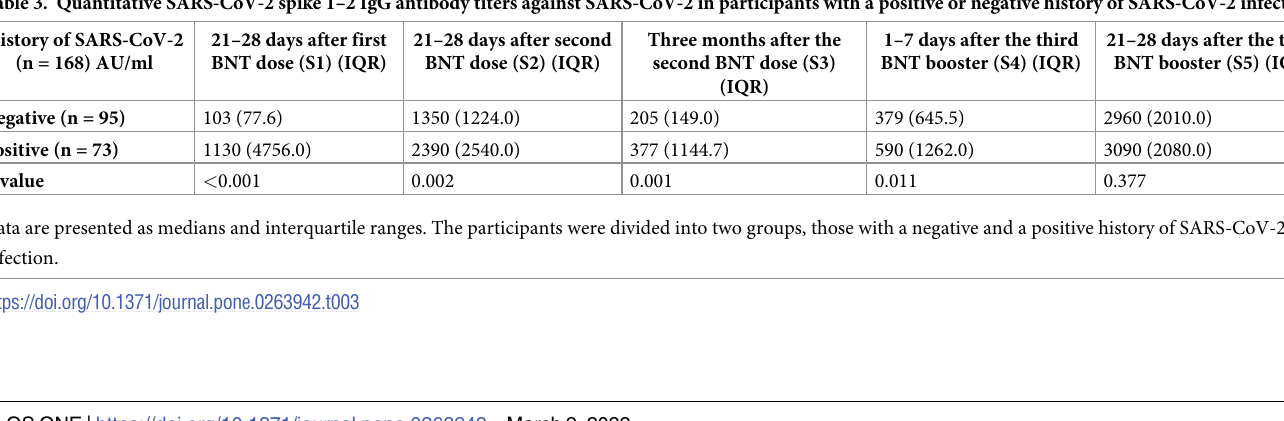
In terms of previous SARS-CoV-2 diagnoses, 95 (56.5%) of the participants reported never having the infection. Seventy-three (43.5%) participants referred a SARS-CoV-2 diagnosis before vaccination and 21–28 days after the third BNT booster. Before vaccination, there were 65 (38.7%) healthcare workers with one confirmed SARS-CoV-2 infection, and 7 (4.2%) that had been infected twice. There were 3 (1.8%) participants with a SARS-CoV-2 diagnosis between the first and second BNT doses, 1 (0.6%) between the second and third BNT doses, and none after the third dose. Table 2 shows the history of SARS-CoV-2 infection among par- ticipants, in frequencies and percentages.